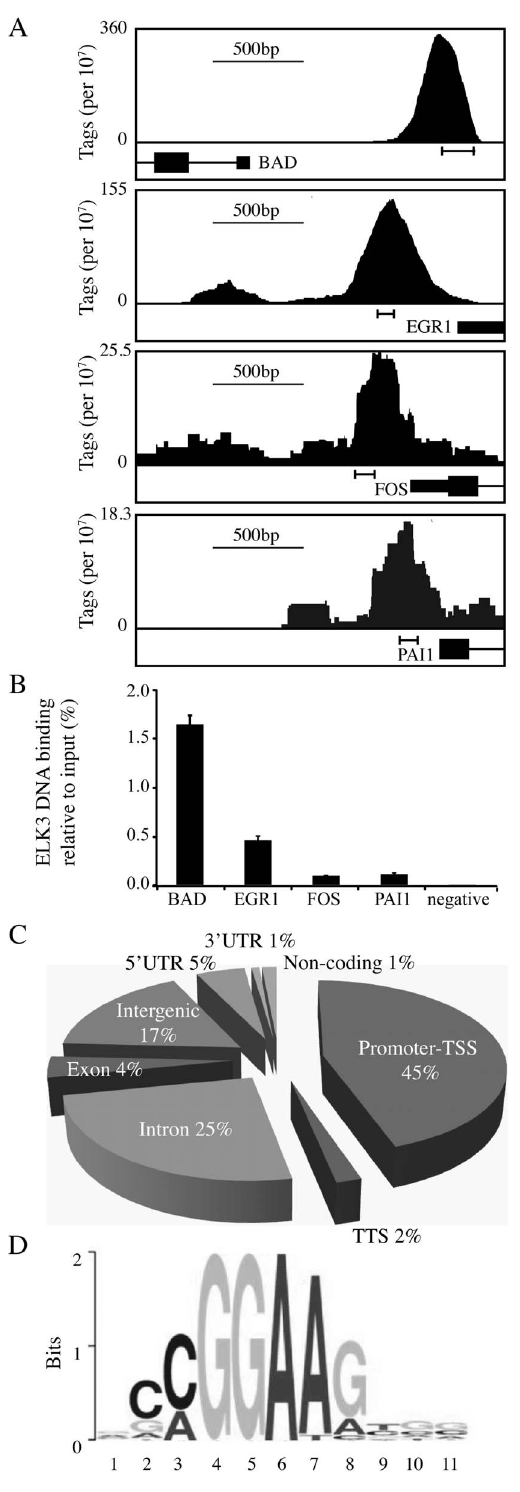
Figure 1. ELK3 DNA binding in HUVEC cells in normoxia. (A) Diagramatical traces of UCSC Genome Browser (http://genome-euro. ucsc.edu/) tracks showing ChIP-seq normalized bedgraphs around the TSS for BAD, EGR1, c-FOS and PAI1. Data is normalised to 10 7 total tags. Each representation shows 2Kb of sequence data. Precise locations are: BAD - chr11:64,051,548-64,053,547, EGR1 - chr5:137,799,444- 137,801,443, FOS - chr14:75,743,992-75,745,991 and PAI1 - chr7:100,768,727-100,770,726. (B) ChIP and QPCR to validate the ChIP-